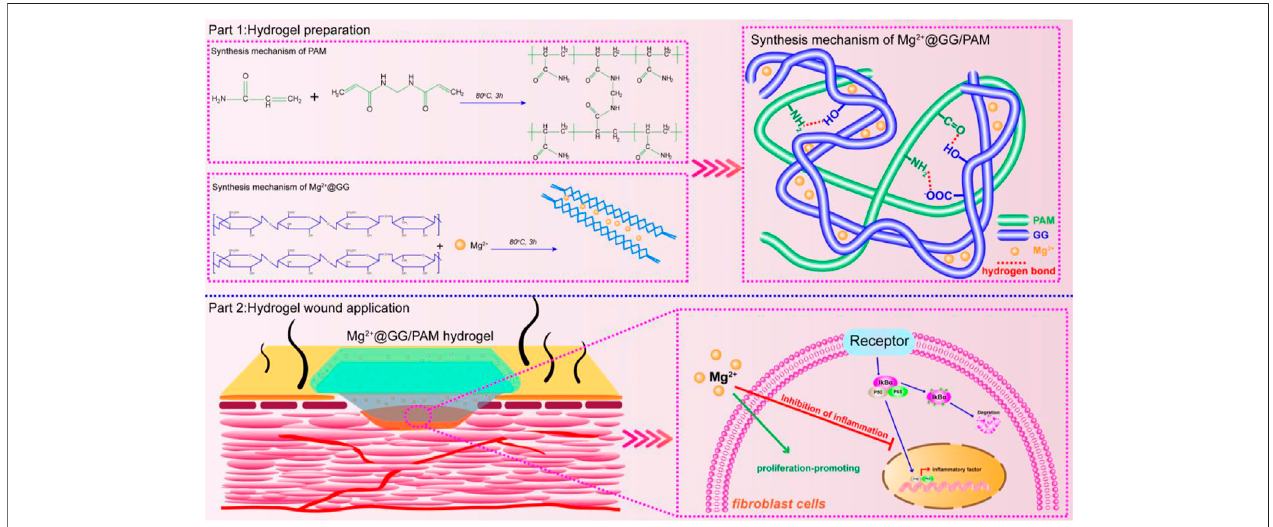
FIGURE 1 | Characterization of Mg 2+ @GG/PAM hydrogel. (A) SEM (B) FT-IR (C) EDS analysis (D) TGA (E) Water vapor transmission rate (F,G) Swelling ratio.